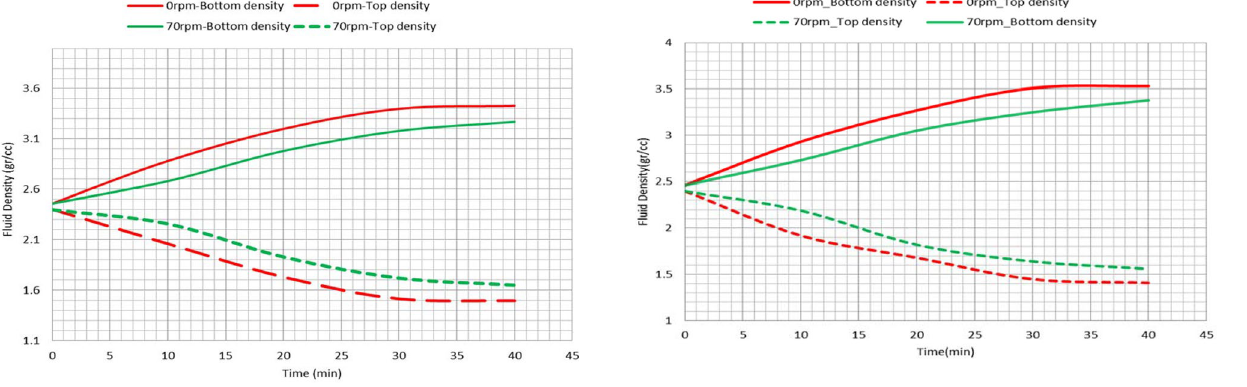
Fig. 3 Changes in the concentration of barite particles in the upstream and downstream of the circulating loop (flow rate of 0.308 l/s and deviation angle of 45°)